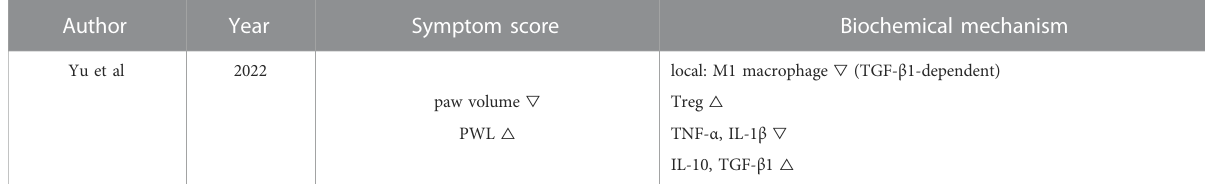
Abbreviation:Bax, Bcl-2-associated X protein; CB1, cannabinoid receptortype 1; D1/D2 receptor,dopamine receptorD1 and D2; GFAP,glial fi brillary acidic protein; HIF, hypoxia-inducible factor; Iba-1, ionized calcium-binding adapter molecule1; IFN- γ , interferon- γ ; IL, interleukin; MDM2, Mouse double minute 2 homolog; MYD88, myeloid differentiation factor 88; N/A, not applicable; NF-kB,nuclear factorkappa-B;NT-3,neurotrophin-3;PUMA,p53upregulatedmodulatorof apoptosis;PWL, painwithdrawallatency; PWT,painwithdrawalthreshold; TGF- β 1, transforming growth factor; Th, T helper cell; TLR4, Toll-like receptor 4; TNF- α , tumor necrosis factor-alpha; Treg, regulatory T cell; TRPV4, transient receptor potential cation